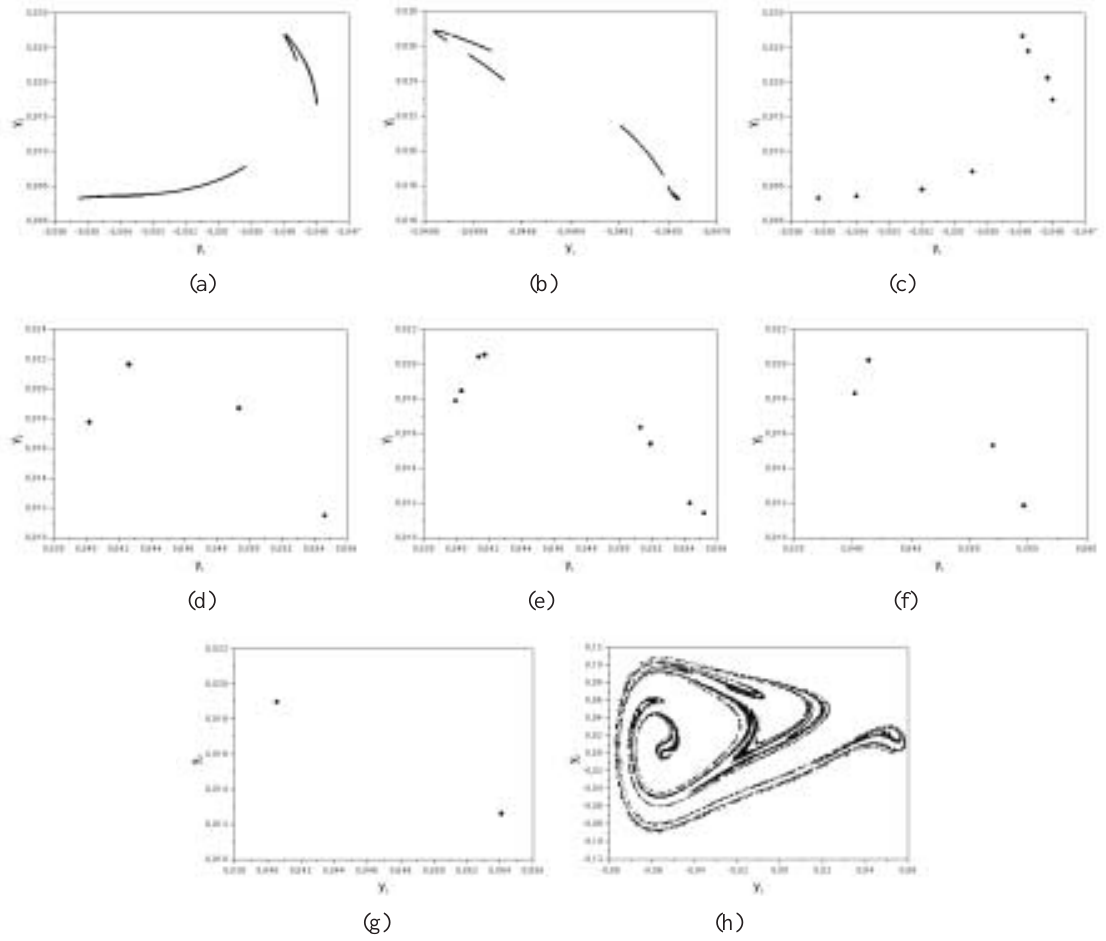
Fig. 15. Evolution of Poincar´e maps due to variation of the temperature parameter θ (formation of a periodic window). (a) θ = 0 . 386 , chaos; (b) θ = 0 . 387 , chaos; (c) θ = 0 . 3875 , period-8; (d) θ = 0 . 389 , period-4; (e) θ = 0 . 38975 , period-8; (f) θ = 0 . 4 , period-4; (g) θ = 0 . 408 , period-2; (h) θ = 0 . 409 ,